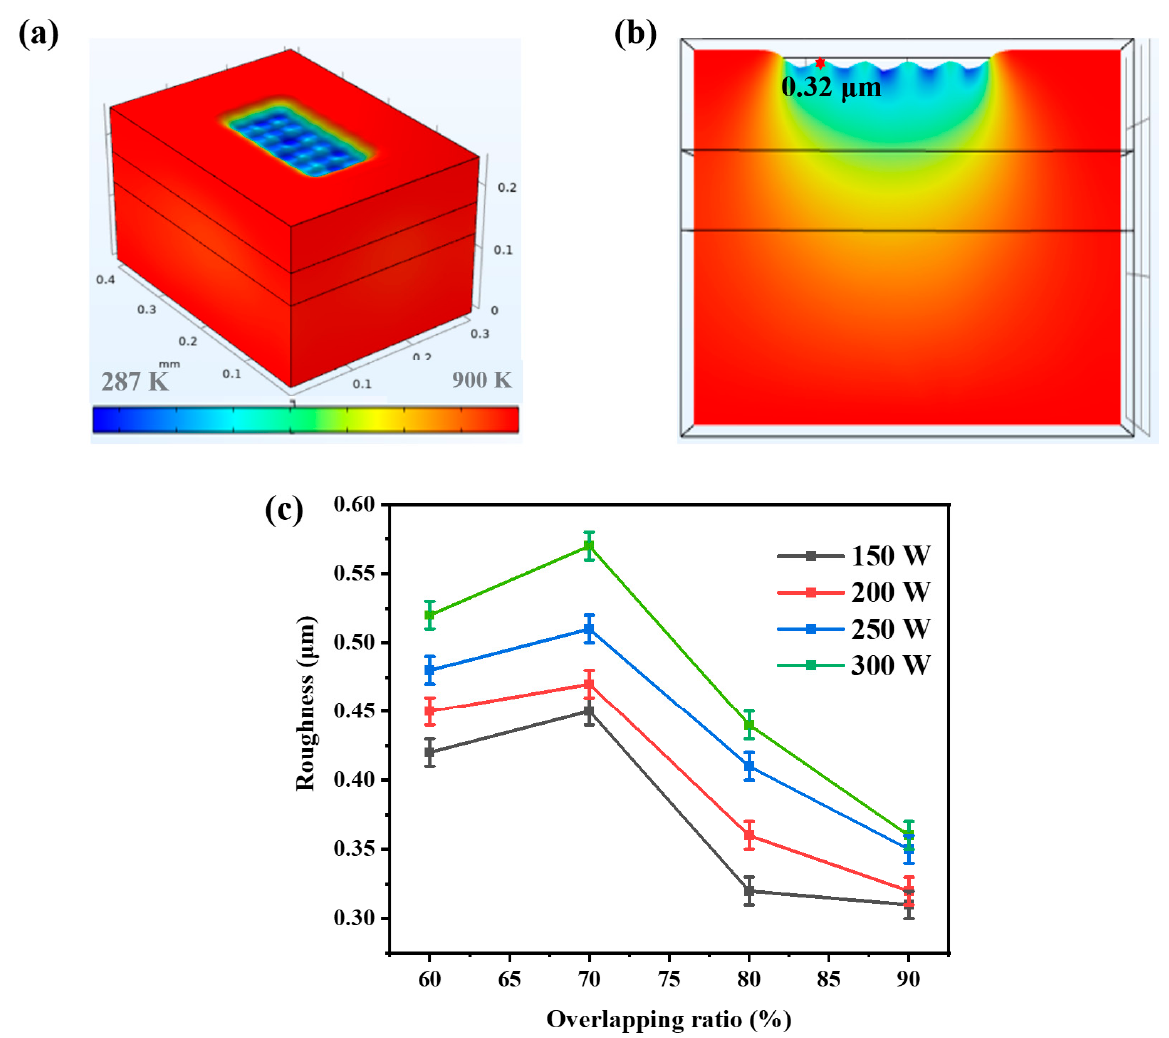
Figure 6. The simulation morphology of ( a ) surface, ( b ) cross section; ( c ) the influence of laser energy and overlapping ratios on surface